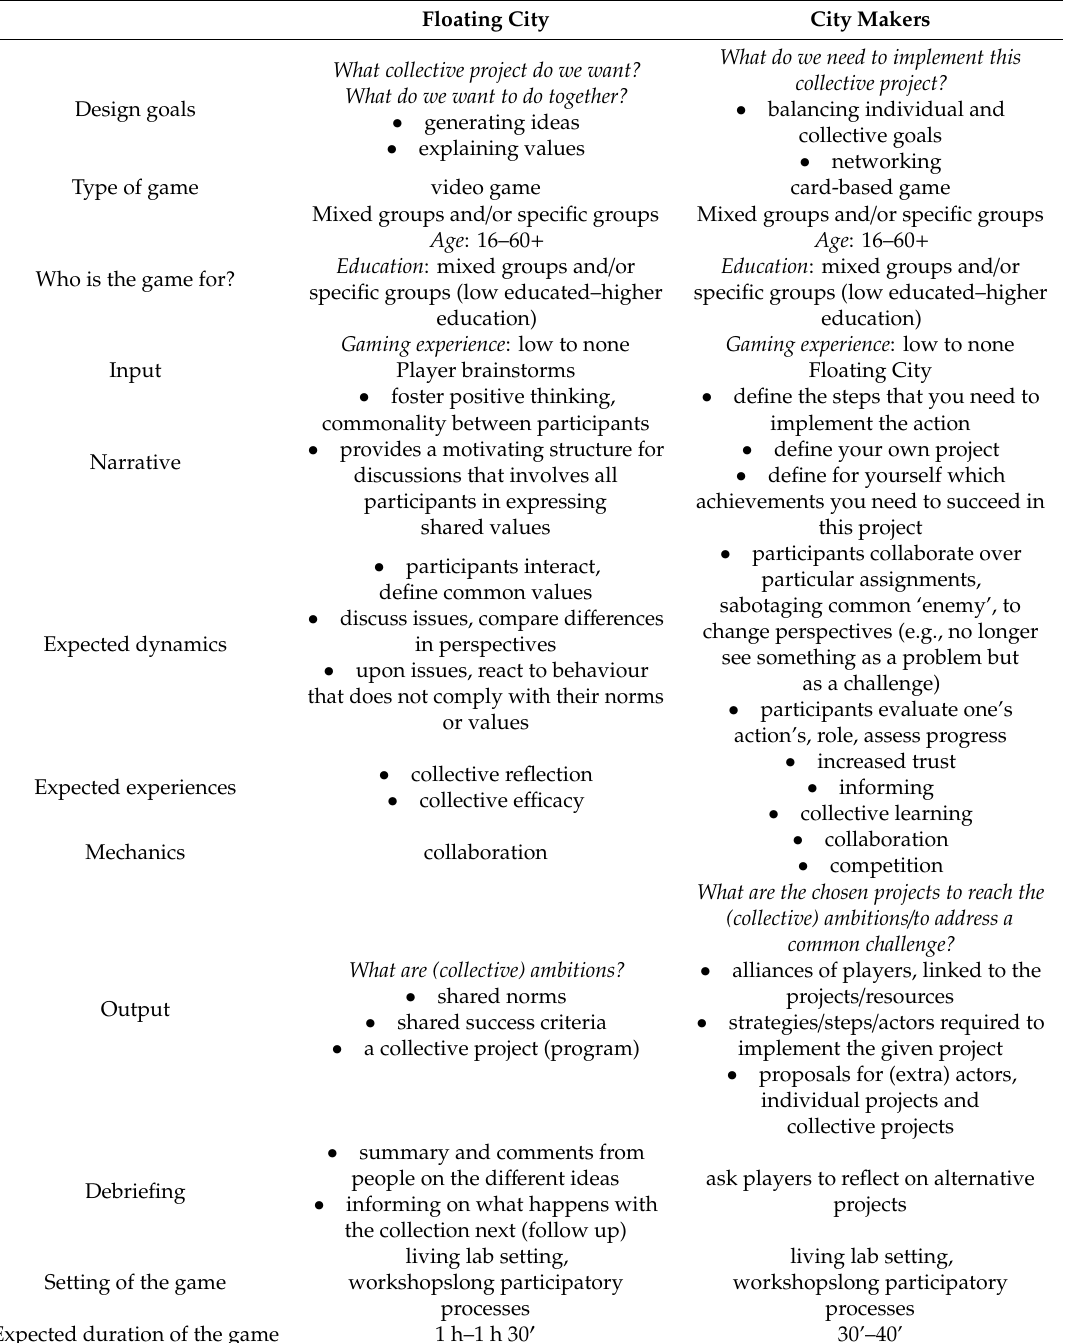
Table 1. Floating city and city makers—design